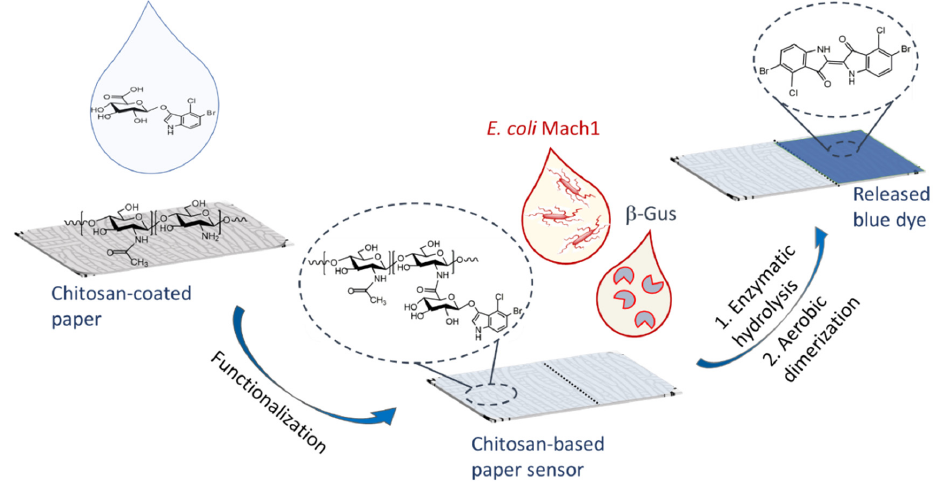
Figure 1. Schematic of paper-based detection of the bacterial enzyme ß-Gus, which is produced by more than 94% of all strains of E. coli [30]. An ultrathin coating of the cellulose fibers with functionalized chitosan affords the colorimetric sensing. The enzyme catalyzed reaction of the chromogenic substrate 5-bromo-4-chloro-3-indolyl- β -D-glucuronide (X-Gluc) affords in the presence of oxygen a deep blue indigo derivative, which is water-insoluble and can be quantified by adequate analysis of smartphone camera photographs.